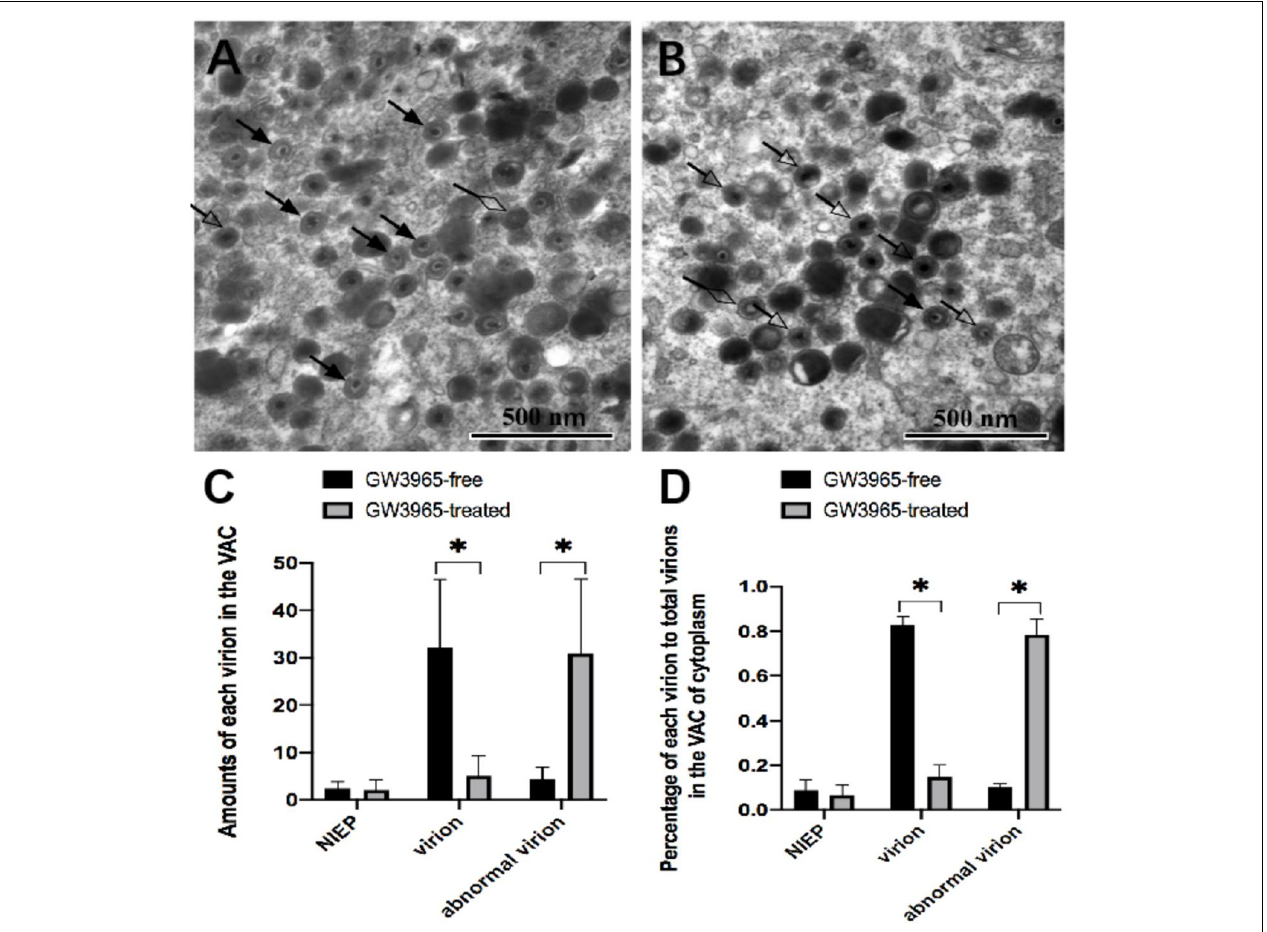
FIGURE 5 | Effects of activated LXR on virion maturation in the cytoplasm of infected cells. NIEP, virions, and abnormal virions can be found in panels (A,B) . The hollow diamond-head arrow points to the non-infectious enveloped particle. The solid arrow indicates the infectious virion. The hollow arrow shows the abnormal virion containing the viral genome but no intact bilayer membrane structure at a magnification of 40,000. The numbers and the percentages of each type of virions in VAC of infected cells treated with or without GW3965 are presented in panels (C,D) , respectively. Data were analyzed by the t -test * P <